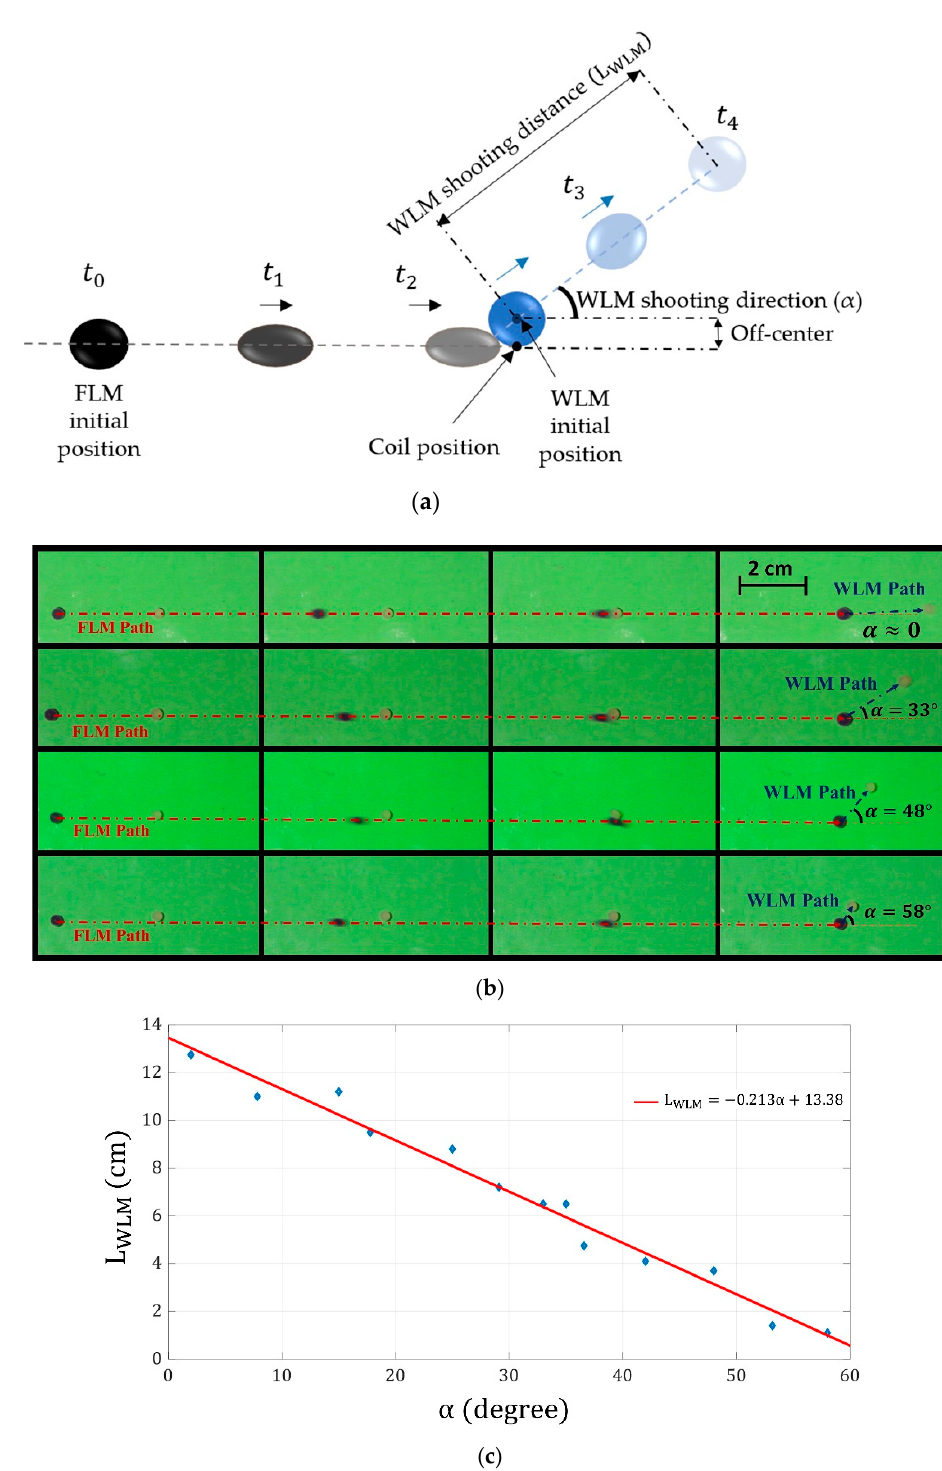
Figure 11. ( a ) Schematic of a WLM placed with an off-center position from the connecting line between the FLM center and the electromagnet tip, leading to a nonstraight WLM motion path. ( b ) A sequence of pictures of the straight and nonstraight collisions between FLM and WLM with volumes of 20 μ L, initial distances of 30 mm and 0 mm from the electromagnet, respectively, and coil current of 3 A. ( c ) WLM shooting distance versus WLM shooting path degree from the FLM path (the red line is fitted linearly to the experimental data.).